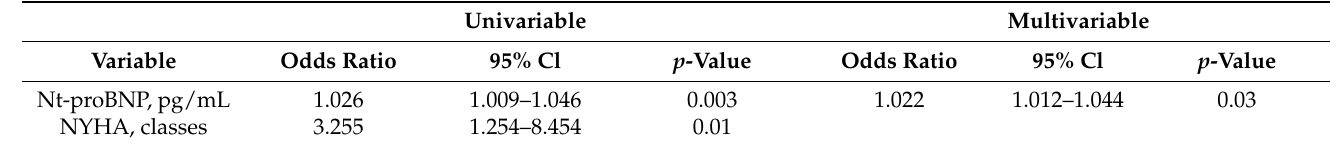
Table 2. Analysis of predictive factors for the occurrence of postoperative sudden cardiac arrest.